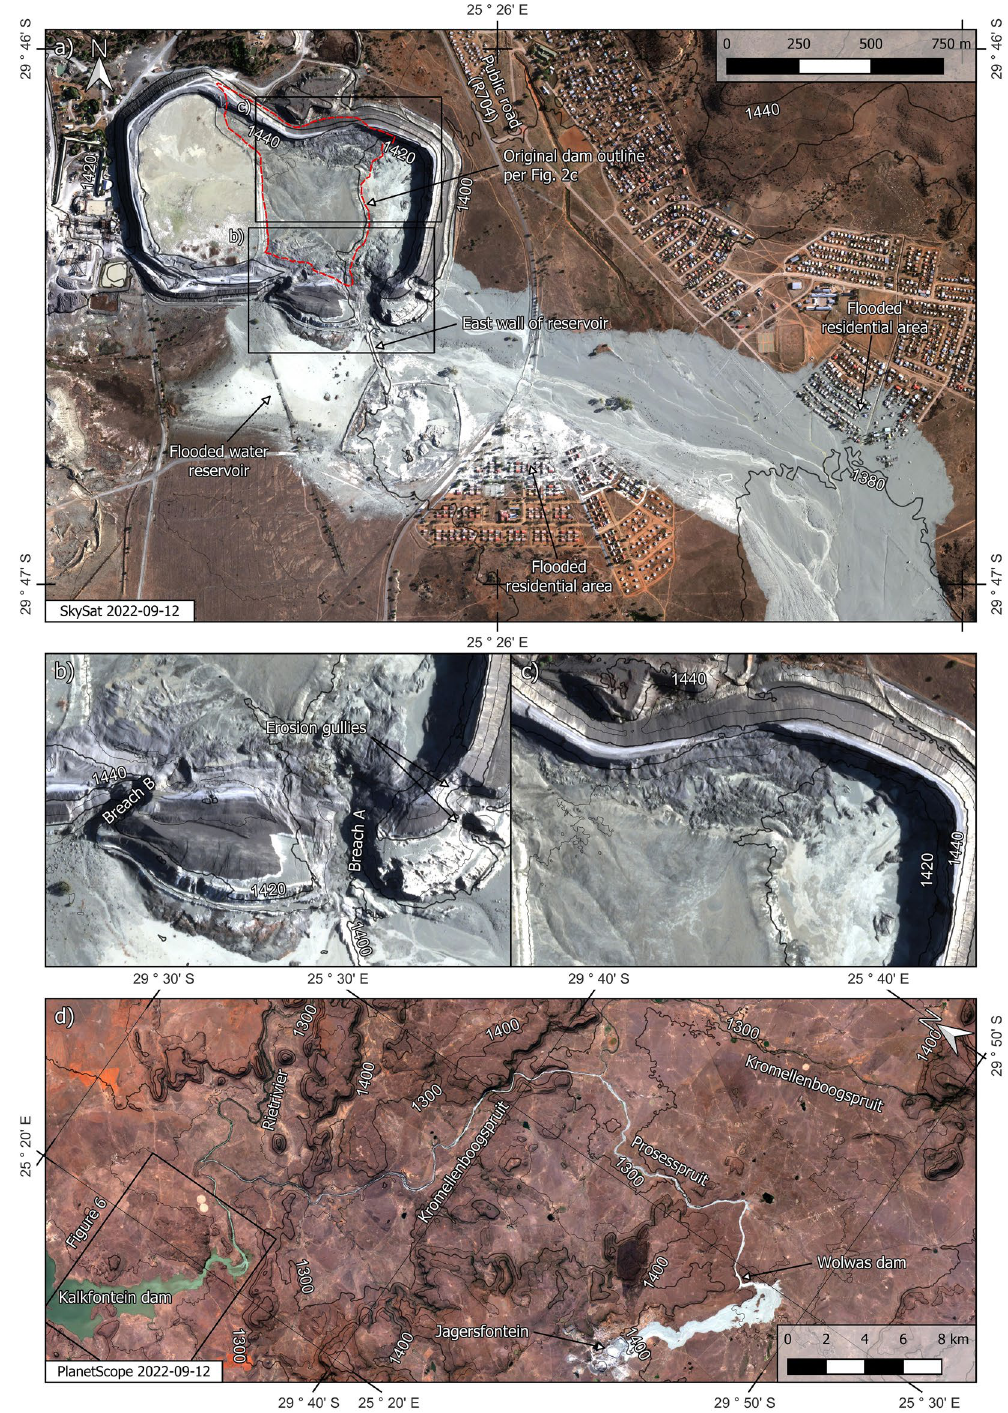
Figure 5. The post-failure scenario. ( a ) Impact on the immediate surroundings. ( b ) Enlargement of breached area. ( c ) Enlargement of collapsed northern wall. ( d ) Full extent of the tailings runout. NB: see also Fig. S2 for expanded version of part ( a ). In part ( d ), words with the suffixes -spruit or -rivier refer to the names of rivers. NB: Contour lines indicate metres above sea level. Created using QGIS software version 3.26 (http:// www. QGIS.